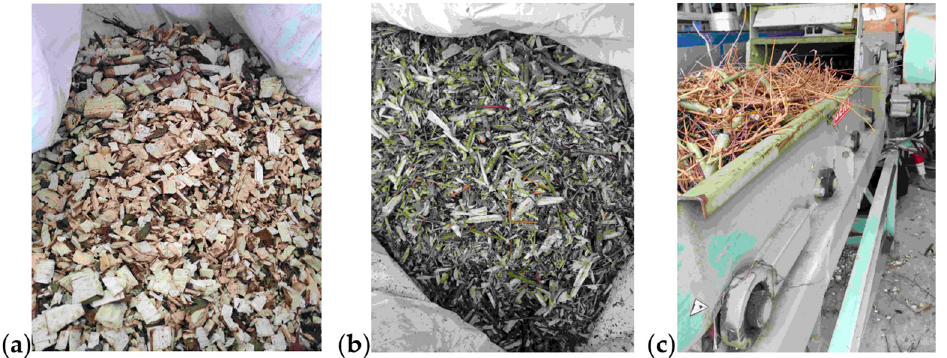
Figure 1. Wood chips from poplar trees ( a ) stem only ( b ) crown only ( c ) chipping machine in operation.